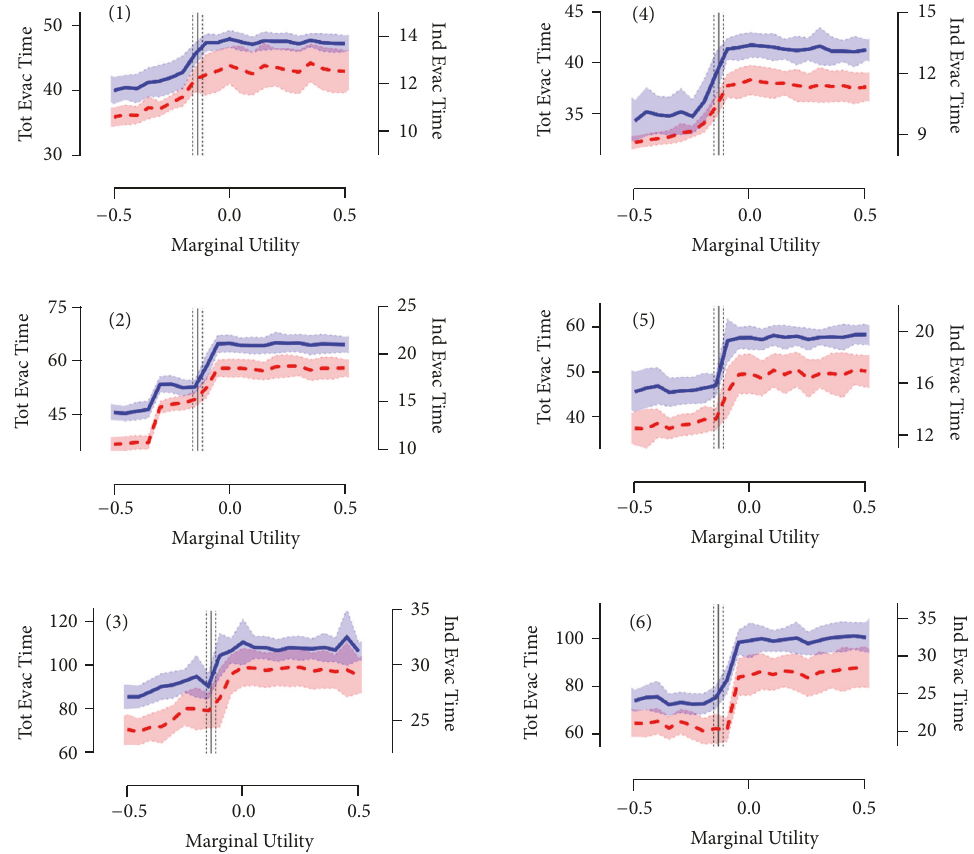
Figure 10: Variations of the simulated total evacuation times (blue solid lines; left vertical axis) and simulated average individual evacuation times (red dashed lines; right vertical axis) as a result of changes in the marginal utility of CONG attribute in exit decision-making of the simulatedevacuees.Errorbandsshowthestandarddeviationsofthemeasurements.Theverticalsolidlinesrepresenttheempiricallyestimated value for the marginal utility of CONG, and the vertical dashed lines visualise the 95% confidence interval of that